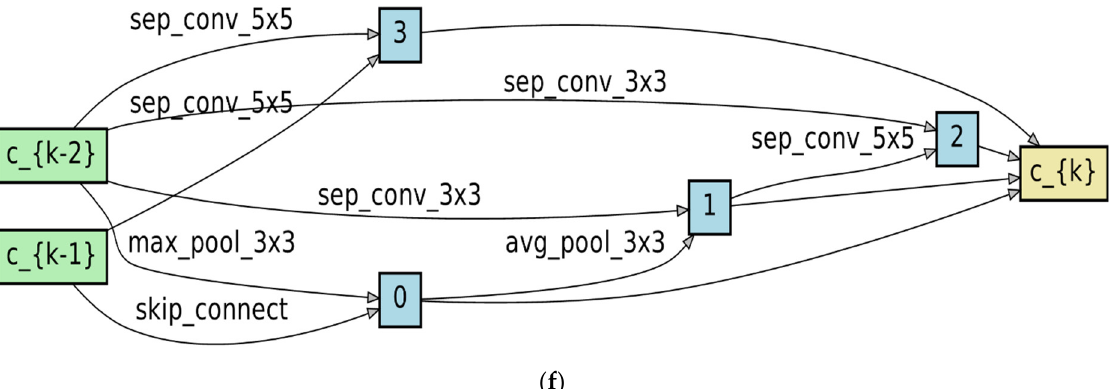
Figure 4. Searched cell architectures of three methods on Large-RS data set. ( a ) Normal cell searched by DARTS. ( b ) Reduction cell searched by DARTS. ( c ) Normal cell searched by PCDARTS. ( d ) Reduction cell searched by PCDARTS. ( e ) Normal cell searched by RS-DARTS. ( f ) Reduction cell searched by RS-DARTS.